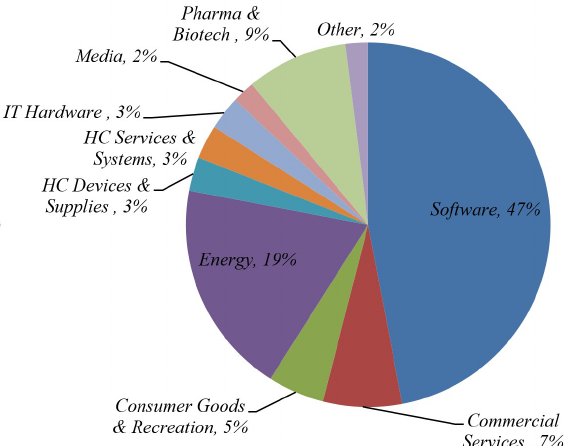
Fig. 2 . Venture capital structure by sectors of the econ- omy of Ukraine, 2017